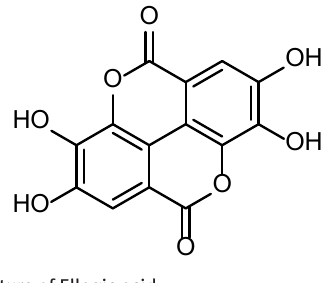
Figure 2 Structure of Ellagic acid